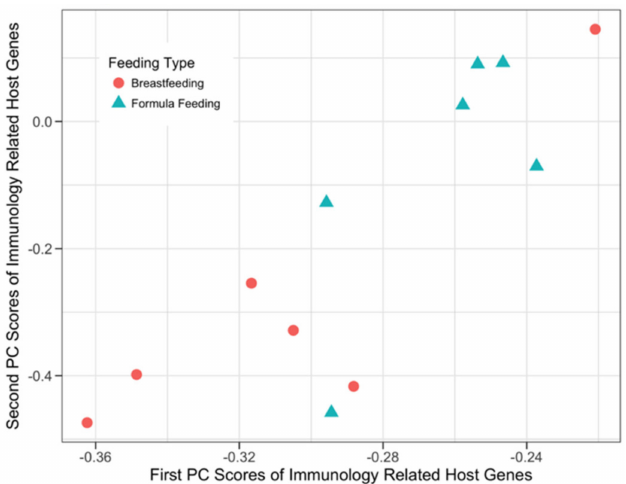
Figure 3. sPCA of immunology and defense related host genes. The x-axis and the y-axis represent the first and the second component scores from the normalized microarray expression of the immunology and defense related host genes, respectively. A total of 76 out of 811 immunology and defense-related genes participated in the first two principal components of this sPCA